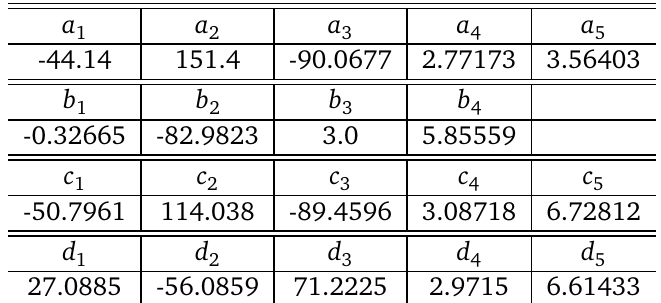
Table 2: Fit parameters of the Poyakov loop potential defined in Eqs. (34) and (59). These are taken from [ 77 ]